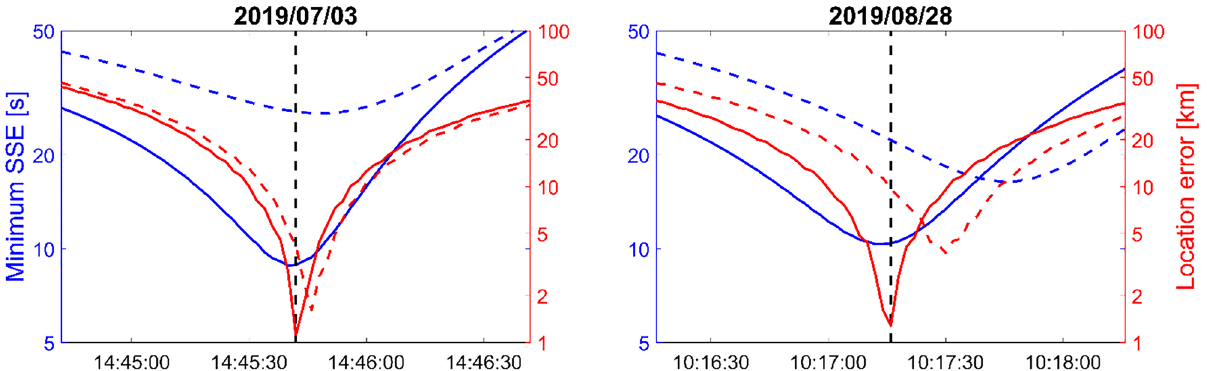
Figure 5. Sum of squared errors (SSE) (blue curves) and location errors (red curves) for the July (left) and August (right) eruptions as a function of trial origin times. Dashed and solid lines correspond to a constant celerity (300 m/s) and azimuthal/range dependent celerity models derived from WASP-3D ray tracing simulations, respectively.